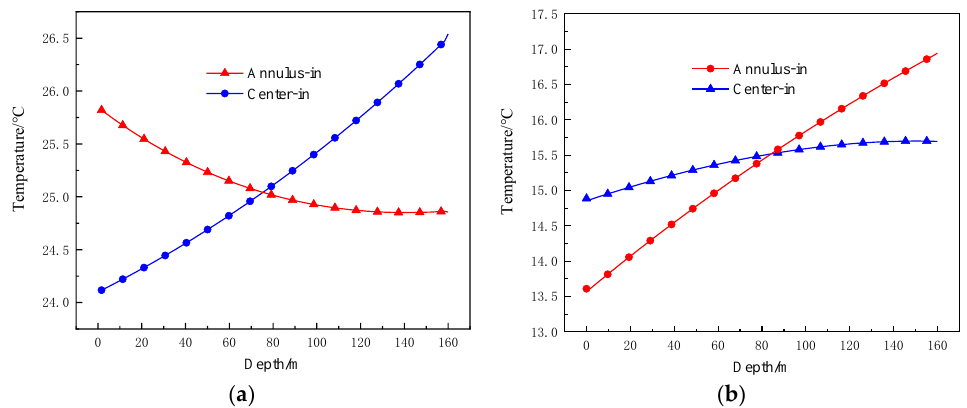
Figure 12. Stratum temperature profile under different working conditions. ( a ) Cooling condition. ( b ) Heating condition.